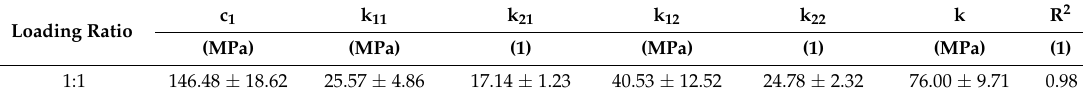
Table 3. The parameters of the model for envelope material under equal loading ratios.